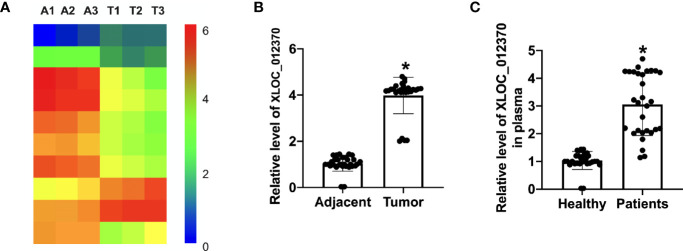
LncRNA XLOC_012370 was upregulation in pancreatic cancer tissues. (A) ChIP analysis of tumor samples. Tumor tissues and adjacent normal tissues were collected from pancreatic cancer patients. (B) The expression of lncRNA XLOC_012370 in tumor tissues and adjacent normal tissues were detected by RT-PCR. n=30, *P < 0.05. (C) The expression of lncRNA XLOC_012370 in plasma from pancreatic cancer patients and healthy volunteers were detected by RT-PCR. n=30, *P < 0.05.